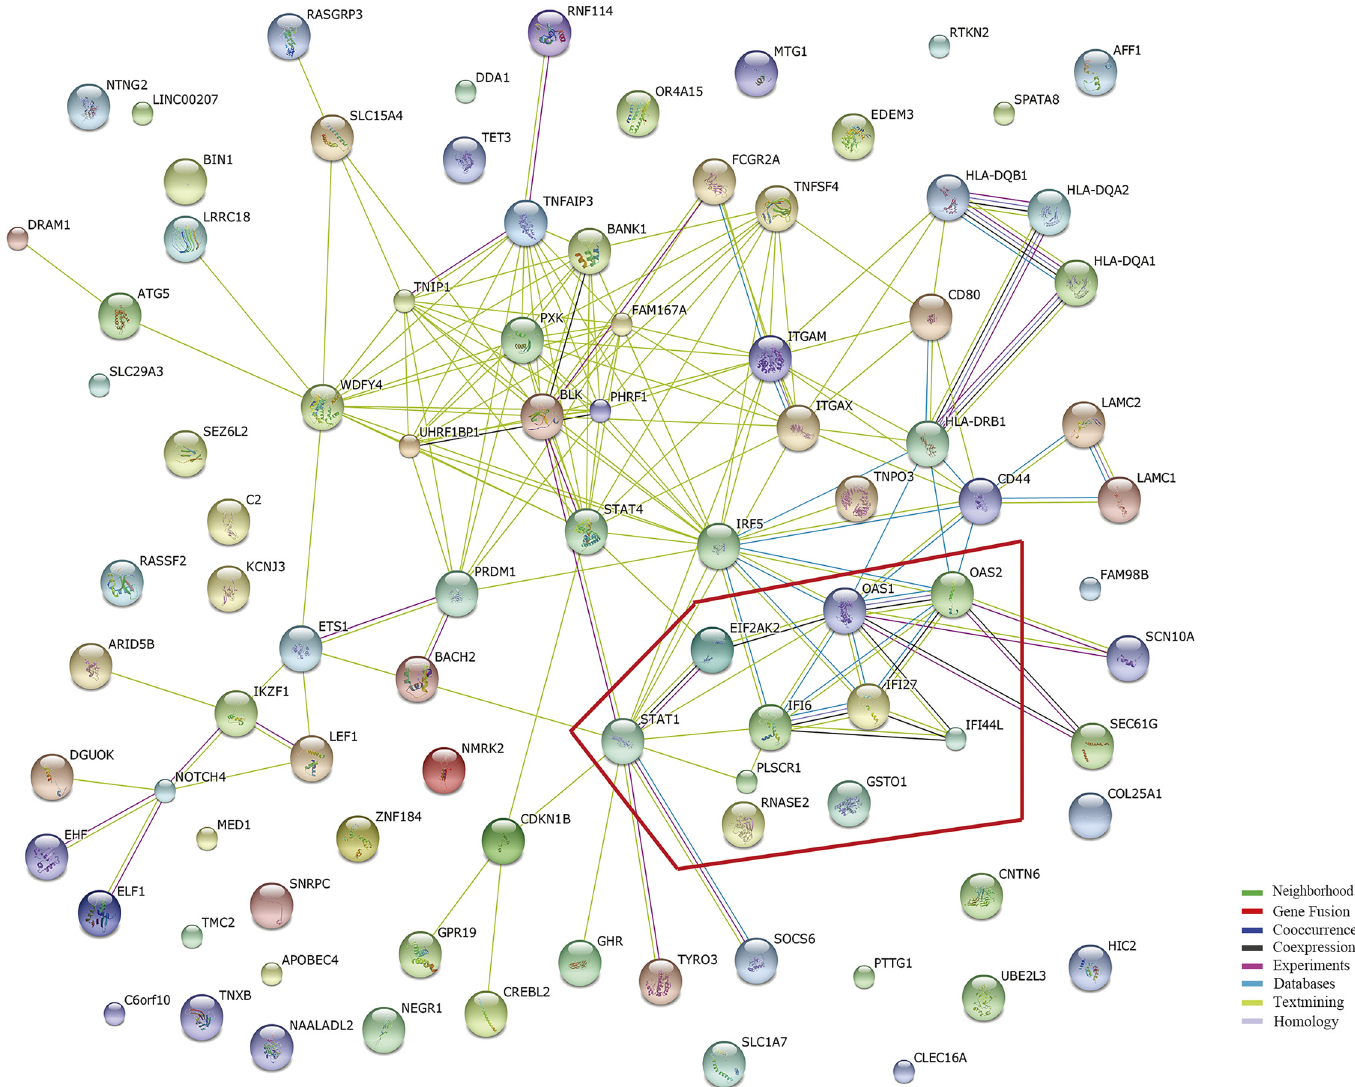
Fig 1. The Evidence View of Protein-Protein Interaction. The PPI were analyzed using the STRING database 10. The predicted functional interaction network is shown in the evidence view where the different line colors represent different types of evidences for the association. The nodes inside the red polygon represent the common genes we identified in the present